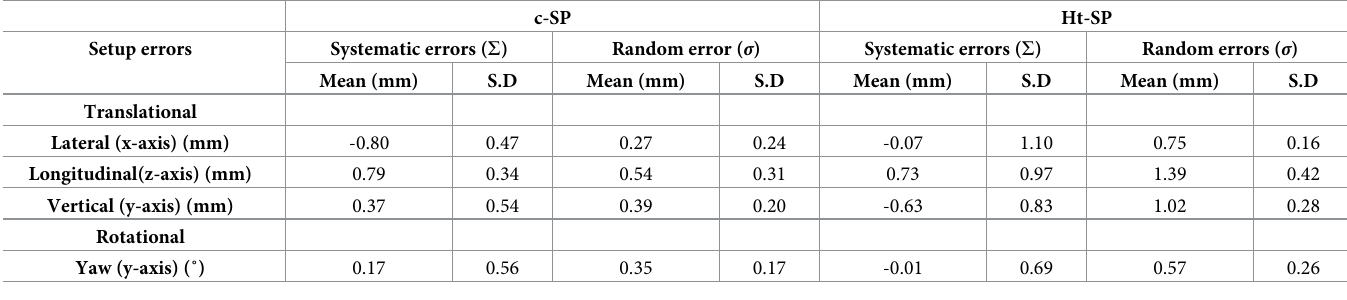
Table 2. Systematic errors ( S ) and random errors ( σ ) in the translational (lateral [x-axis], longitudinal [z-axis], and vertical [y-axis]) and rotational (yaw [y-axis]) directions. c-SP